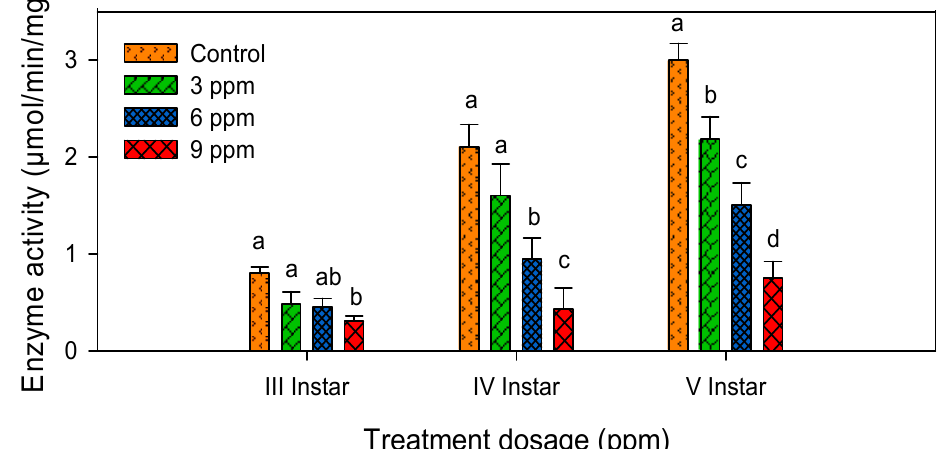
Figure 4. Digestive enzyme lipase activity in third, fourth and fifth instar larvae of S. litura after treatment with andro-